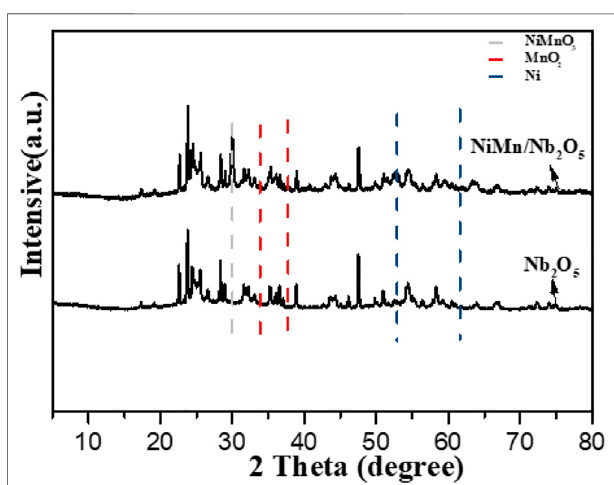
FIGURE 4 | X-ray diffraction pattern of